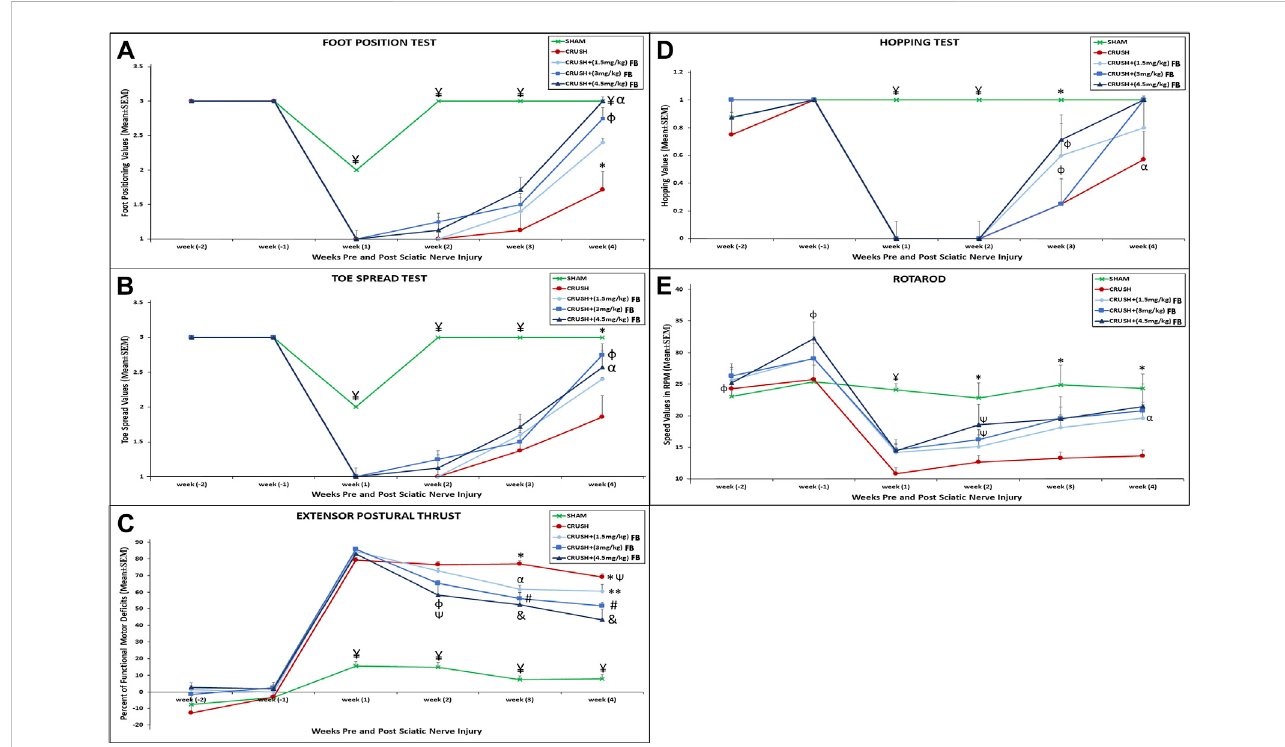
FIGURE 1 (A) Differencesinthemeanvaluesforthefootpositionanalysisfortheexperimentalgroups.¥indicates p < 0.001,SHAMvs.CRUSH,CRUSH+(1.5 mg/kg) FB, CRUSH+(3 mg/kg)FB and CRUSH+(4.5 mg/kg) FB; * indicates p < 0.001, CRUSH vs. SHAM, CRUSH+(3 mg/kg)FB and CRUSH+(4.5 mg/kg)FB; φ indicates p < 0.01, CRUSH+(1.5 mg/kg)FB vs. CRUSH+(3 mg/kg)FB and CRUSH+(4.5 mg/kg)FB; α indicates no signi fi cant difference between SHAM vs. CRUSH+(3 mg/kg)FB and CRUSH+(4.5 mg/kg)FB. (B) Differences in the mean values for the analysis of the spread outcome. The treated rats showed statistically signi fi cant clinical recovery following sciatic nerve injury in toe spread.¥ indicates p < 0.001, SHAM vs. CRUSH, CRUSH+(1.5 mg/kg)FB, CRUSH+(3 mg/kg)FB and CRUSH+(4.5 mg/kg)FB; * indicates p < 0.01, SHAM vs. CRUSH, and CRUSH+(1.5 mg/kg)FB; φ indicates p < 0.01, CRUSH+(3 mg/kg) FB vs. CRUSH and CRUSH+(3 mg/kg)FB; α indicates p < 0.05, CRUSH+(4.5 mg/kg)FB vs. CRUSH and CRUSH+(1.5 mg/kg)FB. (C) Evaluation of functional recovery as measured by EPT following crush injury and FB treatment. EPT was measured by calculating the percentage of the functional de fi cit; thus, a high valueindicatesapooroutcome.¥indicates p < 0.001,SHAMvs.CRUSH,CRUSH+(1.5 mg/kg)FB,CRUSH+(3 mg/kg)FBandCRUSH+(4.5 mg/kg)FB;*indicates p < 0.01,CRUSHvs.CRUSH+(3 mg/kg)FB; φ indicates p < 0.01,CRUSH+(4.5 mg/kg)FBvs.CRUSH; Ѱ indicates p < 0.05,CRUSHandCRUSH+(4.5 mg/kg)FBvs. CRUSH+(1.5 mg/kg)FB; α indicates p < 0.05, CRUSH+(1.5 mg/kg)FB vs. CRUSH; # indicates p < 0.01, CRUSH+(3 mg/kg)FB vs. CRUSH; ** indicates p < 0.01, CRUSH+(1.5 mg/kg)FB vs. CRUSH+(4.5 mg/kg)FB; & indicates p < 0.001, CRUSH+(4.5 mg/kg). (D) Differences in the mean values of the hopping test outcome among the experimental animal groups. ¥ indicates p < 0.001, SHAM vs. CRUSH, CRUSH+(1.5 mg/kg)FB, CRUSH+(3 mg/kg)FB and CRUSH+(4.5 mg/kg)FB; * indicates p < 0.01, SHAM vs. CRUSH, and CRUSH+(3 mg/kg)FB; φ indicates p < 0.05, CRUSH+(1.5 mg/kg)FB and CRUSH+(3 mg/kg) FB vs. SHAM; α indicates p < 0.05, CRUSH vs. SHAM, CRUSH+(3 mg/kg)FB and CRUSH+(4.5 mg/kg)FB. (E) The rotarod test was performed to evaluate motor coordination and motor learning. The treated groups showed marked improvement in this test compared to their performance on the fi rst day of testing. In contrast, the CRUSH group did not show an improvement in the rotarod test. ¥ indicates p < 0.001, SHAM vs. CRUSH, CRUSH+(1.5 mg/kg)FB, CRUSH+(3 mg/kg)FB and CRUSH+(4.5 mg/kg)FB; φ indicates p < 0.05, CRUSH+(4.5 mg/kg)FB vs. SHAM and CRUSH; * indicates p < 0.01, SHAM vs. CRUSH and CRUSH+(1.5 mg/kg)FB; Ѱ indicates p < 0.05 CRUSH+(3 mg/kg)FB and CRUSH+(4.5 mg/kg)FB vs. SHAM; α p < 0.05, CRUSH+(3 mg/kg)FB vs. CRUSH